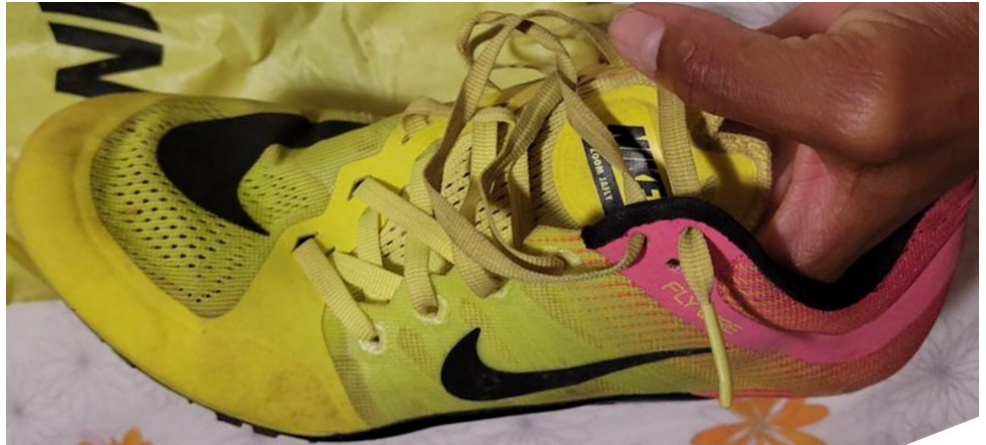
Figure 1. NSS Nike Zoom Jafly 2017.